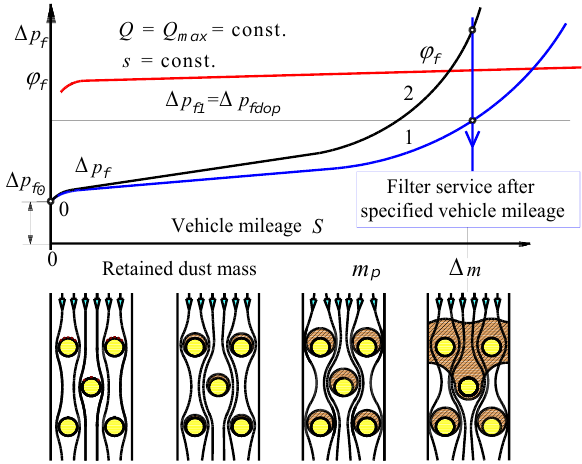
Fig. 2. Changes in separation efficiency and pressure drop of the partition air filter during operation: 1 – low air dustiness, 2 – large air